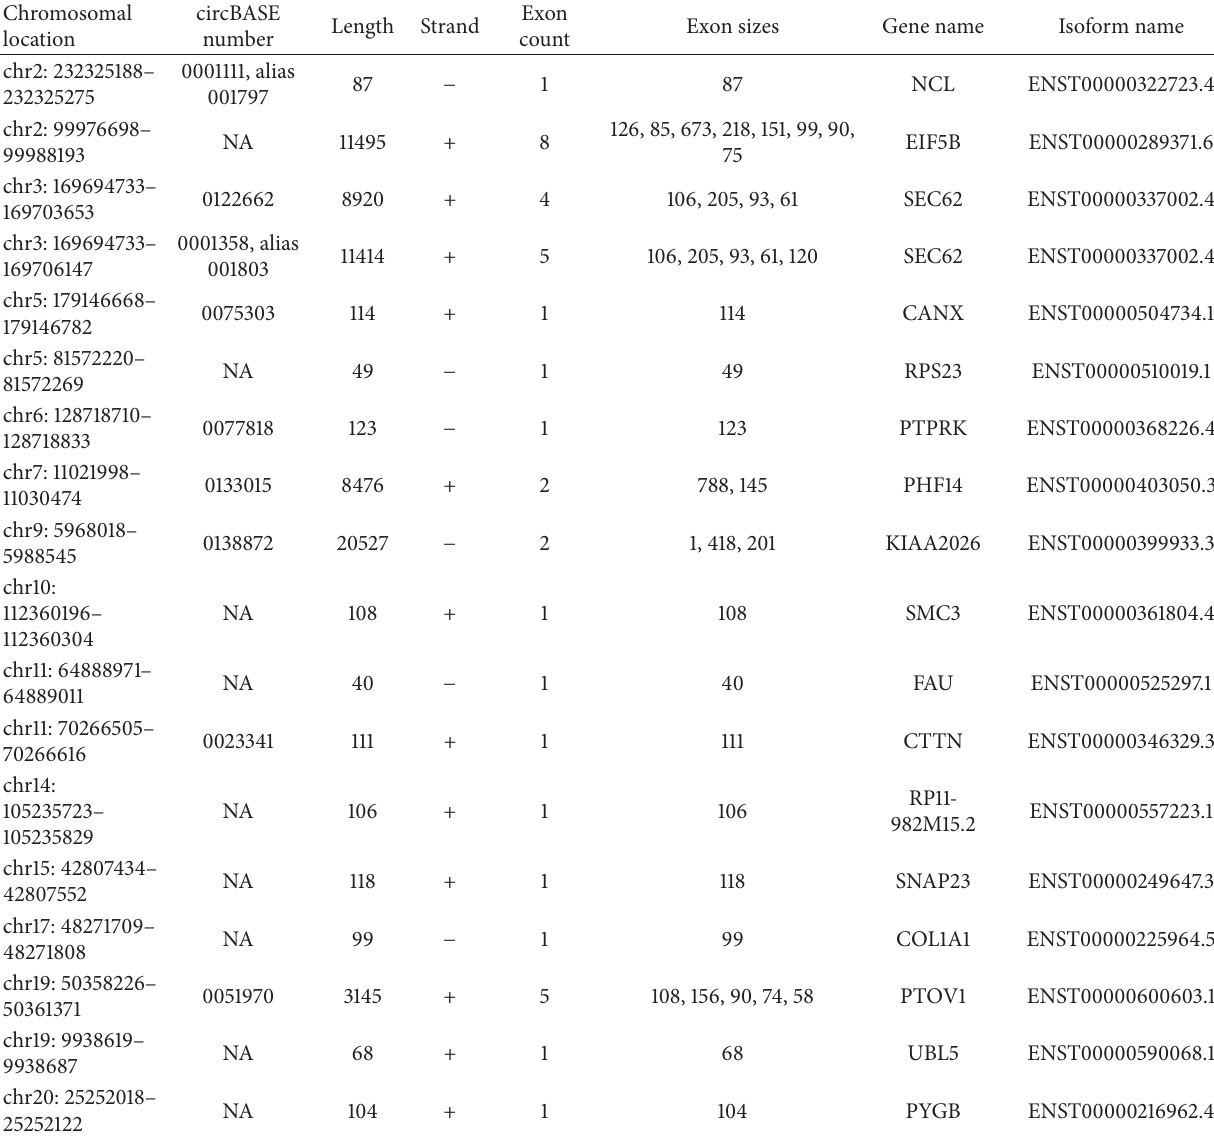
Table 1: The 18 circRNAs expressed in at least one DCIS and IDC sample were listed. The genomic information and the chromosomal coordinate were related to the reference genome human hg19 (GRCh37). Ensemble isoform transcript id names were